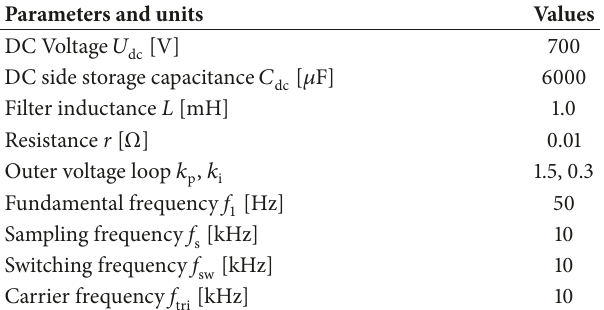
Table 2: System parameters.